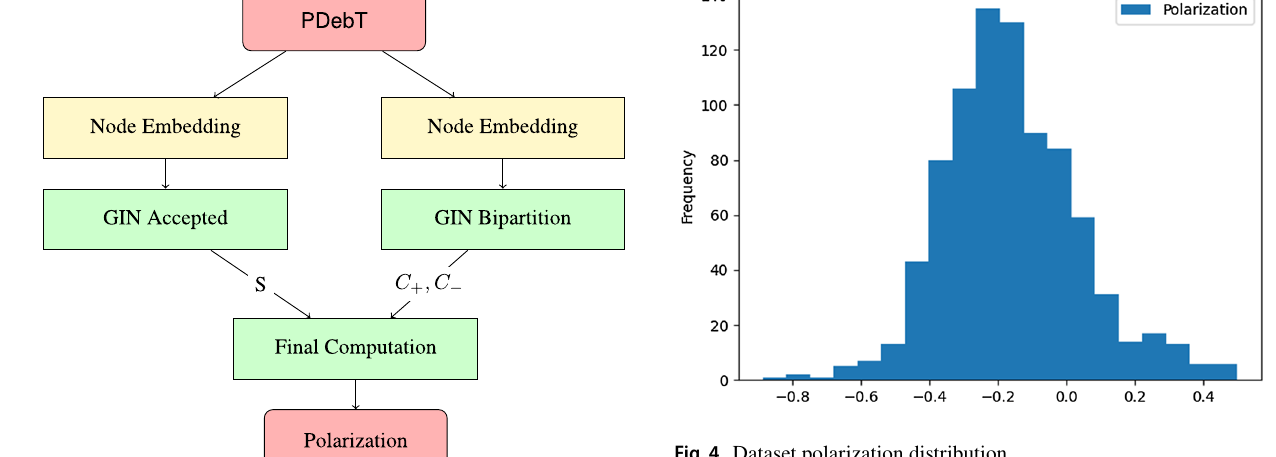
Fig. 4 Dataset polarization